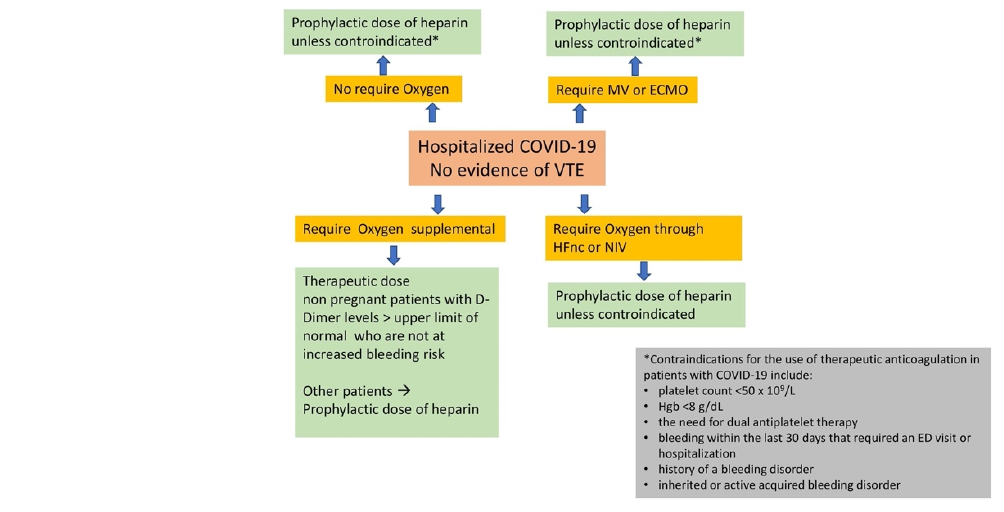
Figure 2. Flow-chart on suggested heparin dosage according to different clinical scenarios.